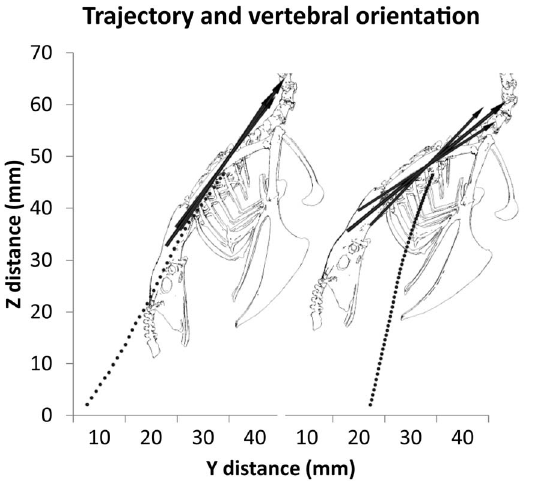
Figure 3. Body pitch and trajectory. Average trajectory of the body (dotted line) compared to the vertebral axis orientation between ascending flight (AF; n=4) and WAIR (WAIR; n=4). The larger middle arrow indicates the mean vertebral pitch, the two smaller arrows are the average maximum and minimum pitch angles for the respective behavior. Note that pitch is less steep, more variable and differs from the trajectory line in WAIR compared to AF. Also, AF is nearly twice as fast as WAIR as indicated by the space between points sampled every 20 ms.